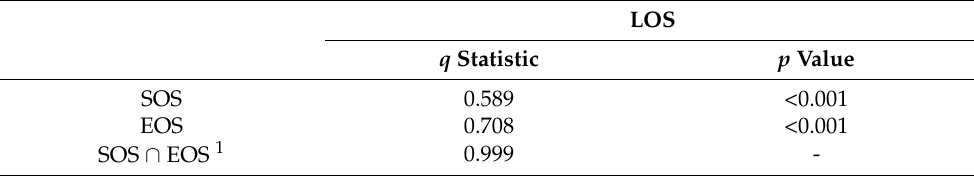
Table 2. Interpretation of LOS change trend by SOS and EOS. LOS q Statistic p Value SOS 0.589 <0.001 EOS 0.708 <0.001 SOS ∩ EOS 1